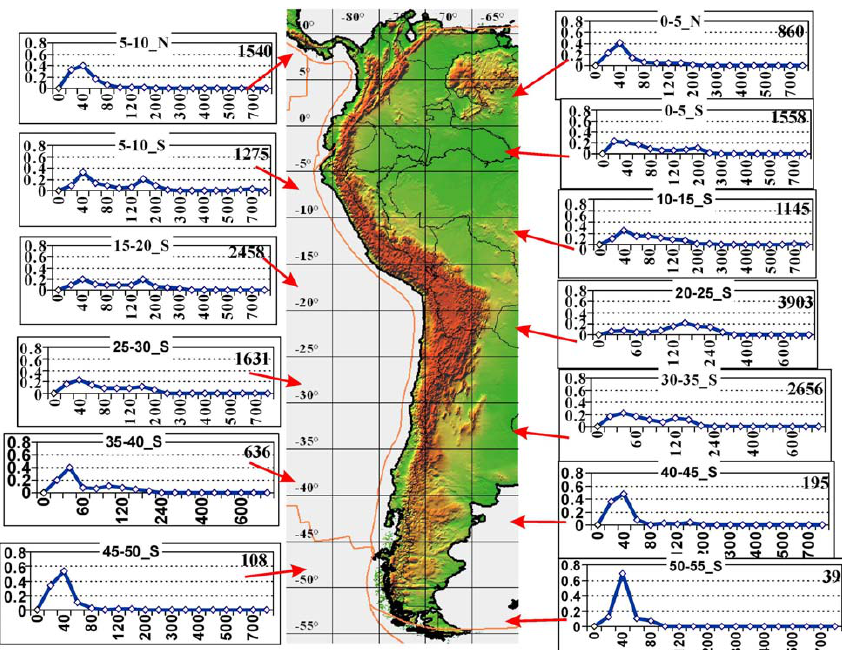
Figure 6. The depth distributions of the EQs in each latitudinal belt (size of belt is equal to 5 ◦ ) are shown in 13 plots. The vertical axes of all presented plots are relative number of the EQs in given latitudinal belt; the horizontal axes are depth in km (nonuniform scale). The red arrows indicate on the correspondent latitudinal belt. The total number of events in given latitudinal belt is shown in the upper right corner of every plot.